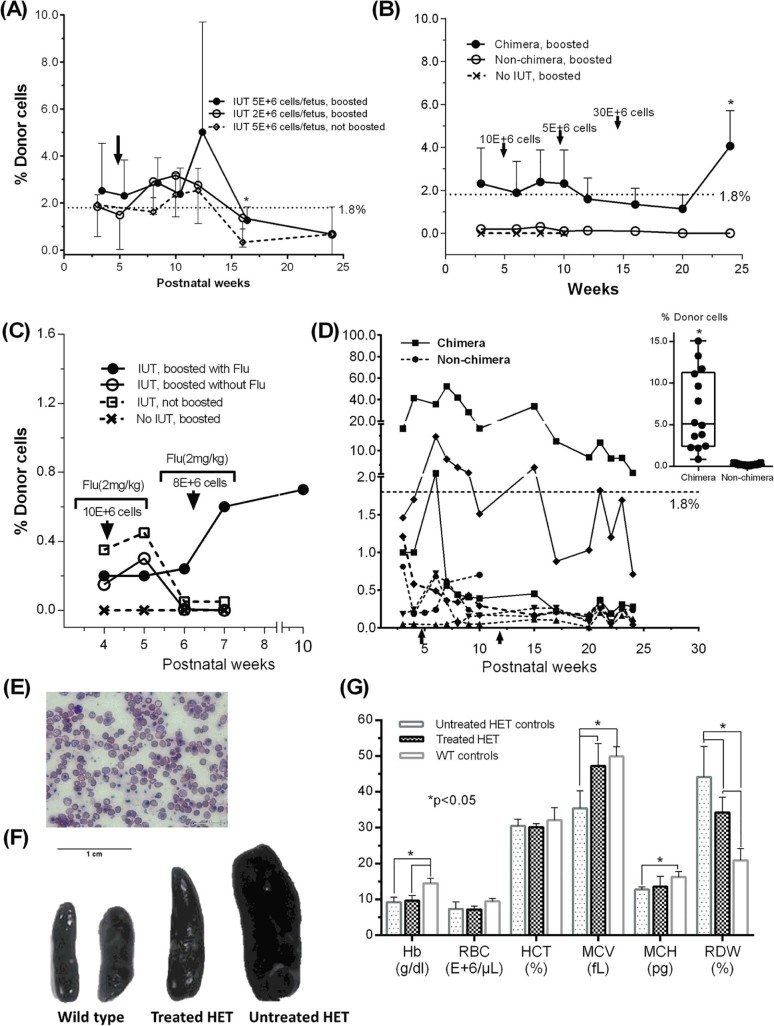
Postnatal transplantation to boost chimerism after intrauterine transplantation. Adult BM mononuclear cells were postnatally transplanted into chimeric and nonchimeric IUHCT recipients to boost engraftment. Black arrows indicate time points of postnatal transplantation. (A) BMHD and BMLD IUHCT recipients were given 5E+6 cells IV at 5 weeks. BMLD produced 2.0 ± 0.9% chimerism (range 0.7–3.2%) and BMHD produced 2.7 ± 1.2% chimerism (range 1.3–5.0%, p = 0.3). Both lost chimerism after 16–20 weeks. Unboosted BMHD controls maintained 1.6 ± 0.9% chimerism. (B) Multiple boosts to BMLD chimeras and nonchimeras with 5–30E+6 BM cells produced higher donor cell levels in chimeras (2.1 ± 0.9 vs 0.1 ± 0.1, p < 0.001), which was maintained mostly >1.8% until 24 weeks. Non-IUHCT-boosted mice (n = 3) showed no postnatal chimerism. (C) Transient immunosuppression was produced with IV fludarabine in BMLD recipients (<1% chimerism after IUHCT) before postnatal boosts of 10E+6 BM cells at 4 weeks and 8E+6 cells at 6 weeks. Fludarabine-treated mice maintained chimerism at 0.2–0.7% after the second boost and had higher donor cell levels than non-fludarabine-treated controls (0.4 ± 0.2% vs. 0.1 ± 0.1% respectively, p = 0.3). IUHCT mice with and without postnatal boost and non-IUHCT-treated pups transplanted postnatally showed minimal or no chimerism. (D) BMHD mice were treated with fludarabine and 10E+6 cells twice at 4 and 10 weeks. Chimeras showed increased donor cell levels after each boost (overall chimerism 6.7 ± 4.6%) before eventual wastage to <1% by 24 weeks. Nonchimeras did not show improvement after either boost (inset). Two treated chimeras maintained levels of 2.3–52.4% and 1.0–14.7% and were HET by genotype. Both had ongoing hemolysis (E) and smaller (though still enlarged) spleens (F) compared with nonchimeras. (G) Treated HET mice showed increased MCV and reduced RDW compared with untreated HET mice (47.3 ± 6.2 fL vs. 35.4 ± 4.9 fL, and 34.3 ± 4.3% vs. 44.1 ± 8.6%, respectively, p < 0.05), approaching the levels of WT. Treated HET mice had lower Hb than WT, but there were no differences in MCV and MCH (49.9 ± 2.6 fL vs. 47.3 ± 6.2 fL and 16.2 ± 1.6 pg vs. 13.6 ± 2.9 pg, respectively, p > 0.05). *p < 0.05.